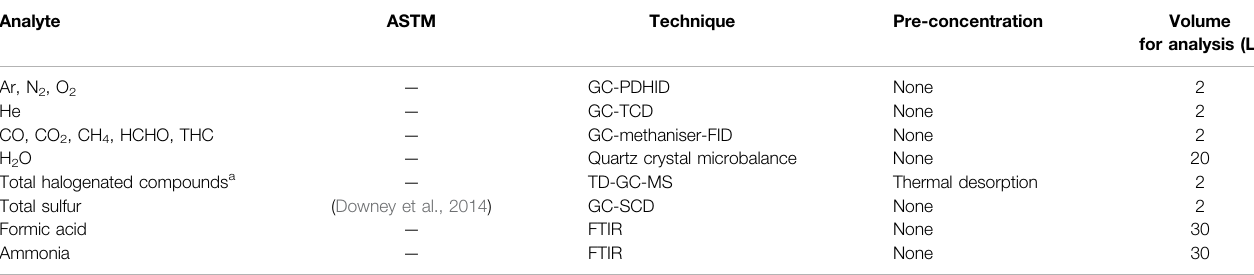
TABLE 4 | Analytical instrumentation used by